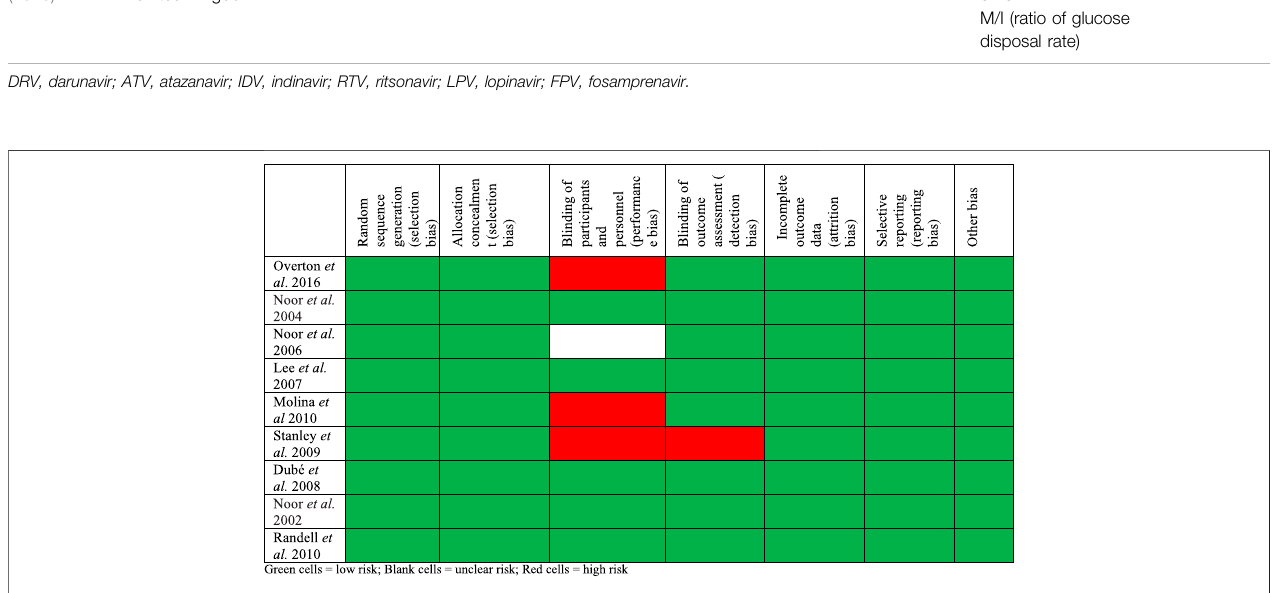
Frontiers in Pharmacology |